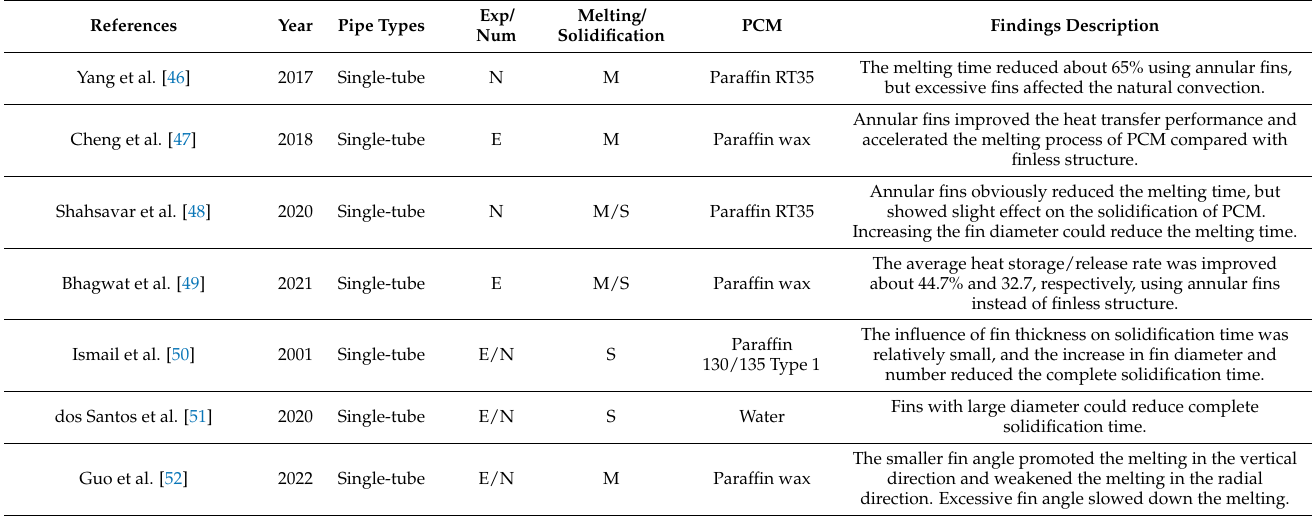
instead of finless